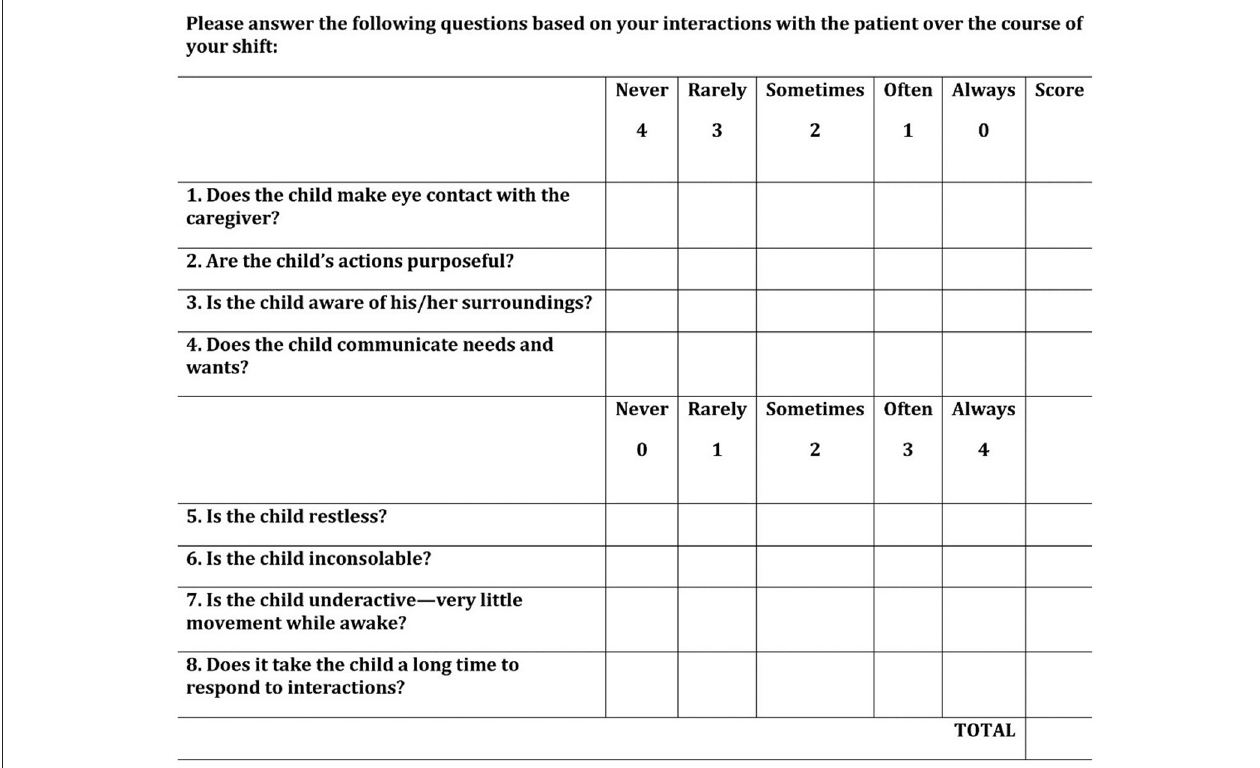
FIGURE 1 | Cornell Assessment for Pediatric Delirium (CAPD). The CAPD is a rapid bedside screening tool validated for delirium detection in children of all ages. A score of nine or higher is consistent with a diagnosis of delirium, and has been shown to correlate with patient outcome measures. [Reproduced from reference ( 19), with permission of Wolters Kluwer